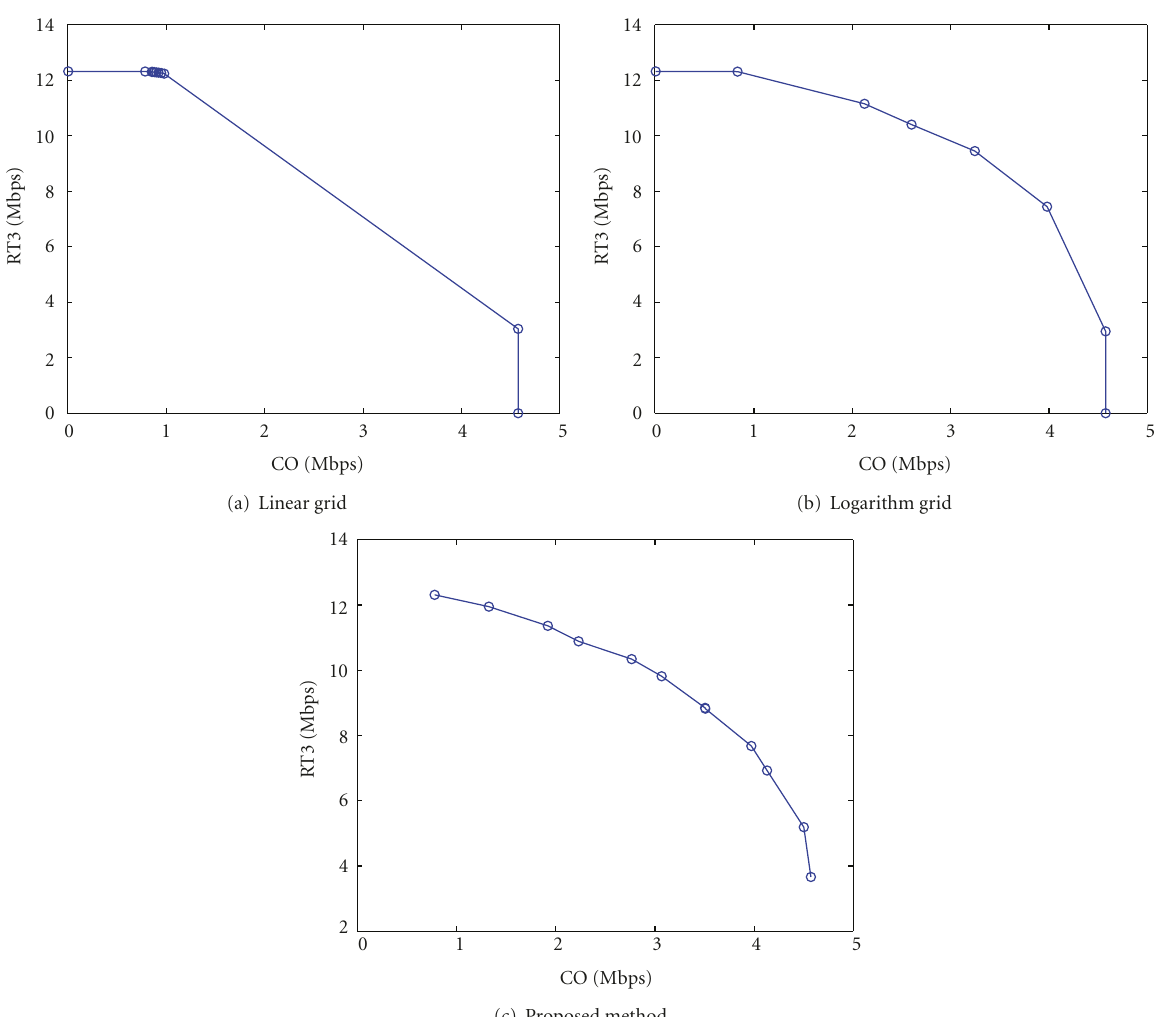
Figure 5: Operating points using (a) linear grid, (b) logarithm grid and (c) proposed diverseSB for the 2-user case. All three methods used 144 SB runs and provided Z = 12 points (some points cannot be distinguished visually, such as one pair in (c)). Note that, in this case, the linear grid was clearly outperformed by the other two methods, while the proposed method is slightly better than the logarithm grid.